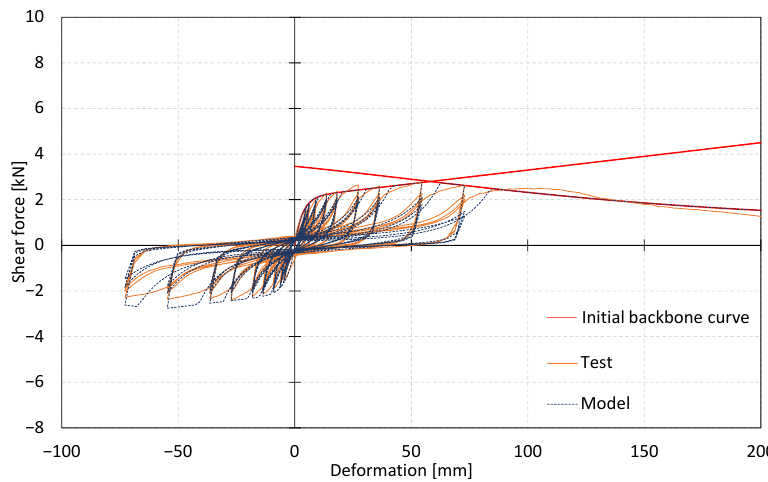
Figure 10. Comparison between test results and prediction (Gypsum board). Table 4. Parameter of analysis.